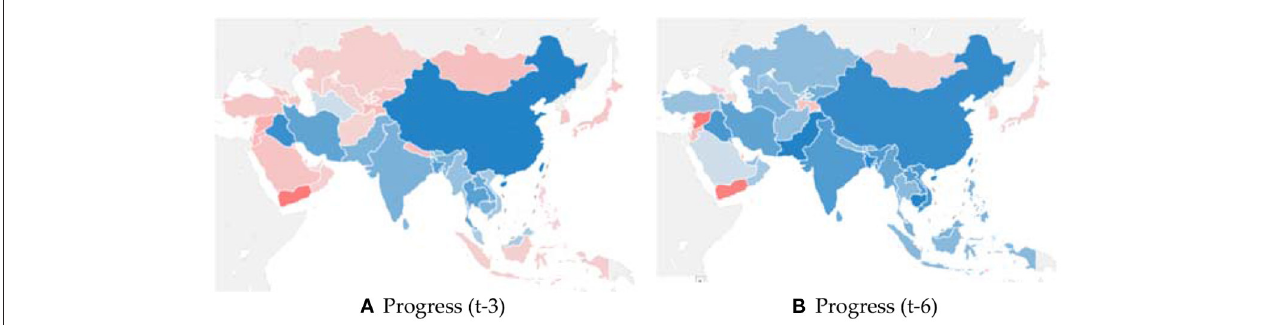
FIGURE 2 | Progress score in different time spans. (A) Subfigure a is the geographical distribution of progress score in the past 3-year period (namely 2013–2016), while Subfigure b is that in the past 6-year period (namely 2010–2016), which calculated by the CAGR; (B) Blue indicates progress toward to green economy, red indicates movement away from green economy. The darker the color, the stronger the progress or movement away that occurred over the respective time span.